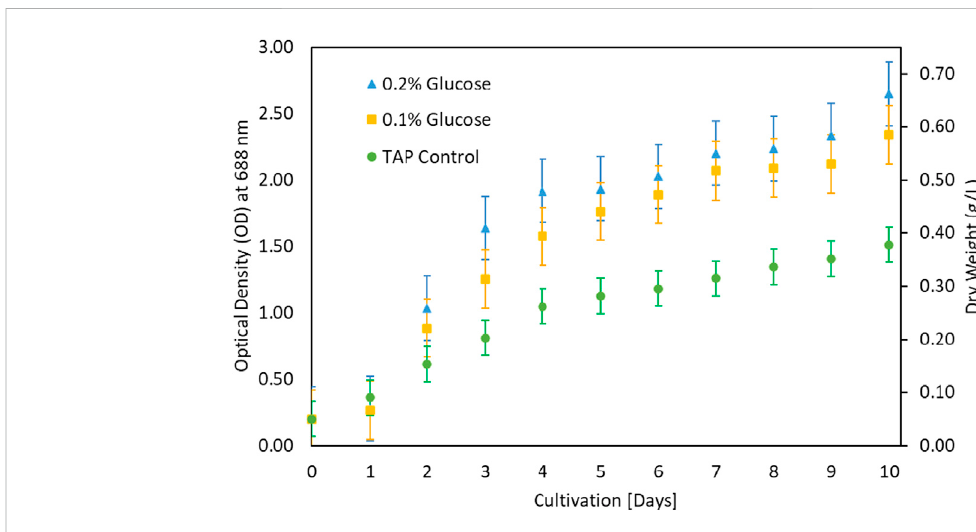
FIGURE 3 Growth comparison after glucose addition in TAP